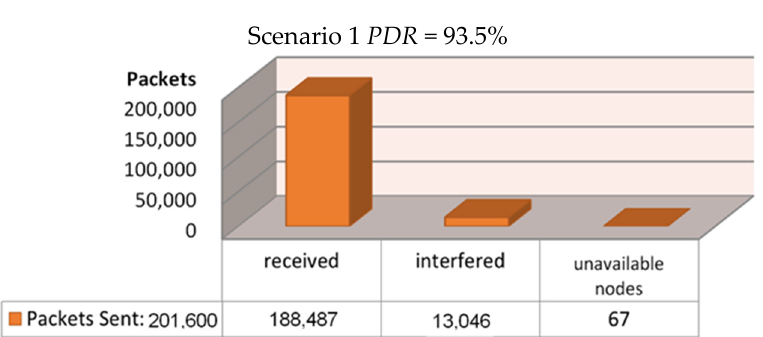
Figure 9. Scenario 1—Regarding the setup’s effectiveness once installing the gateway at the geomet- rical center of the building.